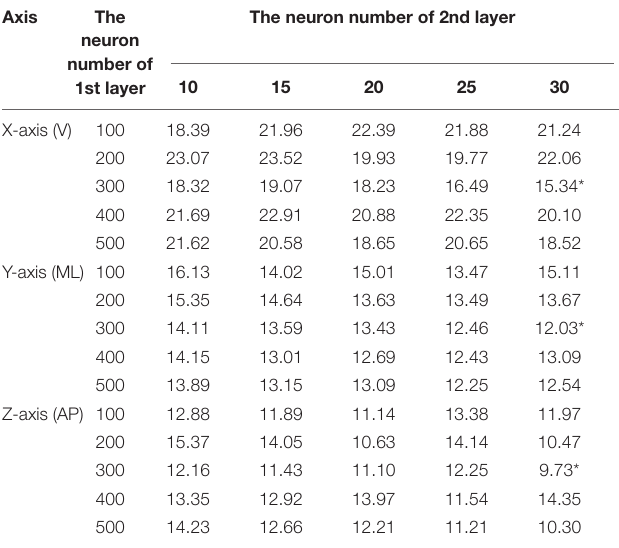
TABLE 4 | Mean squared errors for different combinations of neuron numbers in the first and second layers of the two-layer AE for the X-axis (V), Y-axis (ML), and Z-axis